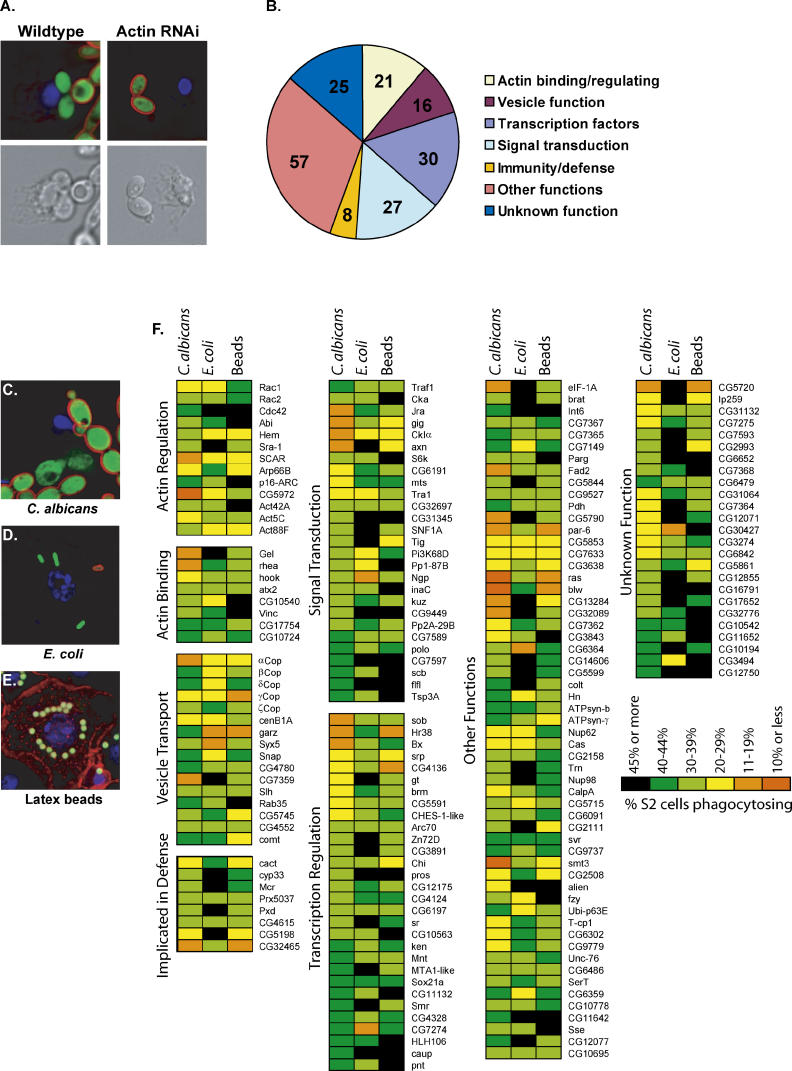
Identification of Genes Required for Phagocytosis of C. albicans
(A) High-throughput assay for phagocytosis. GFP-expressing C. albicans (green) were co-incubated with S2 cells to allow phagocytosis. Cells were lightly fixed, and non-phagocytosed C. albicans were secondarily labeled with a rabbit anti–C. albicans antibody and Cy3-labeled anti-rabbit antibody (red). S2 cell DNA (blue) was labeled with Hoechst 33258. Left panels, wild-type S2 cells; right panels: S2 cells treated with RNAi against actin (Act5C).(B) One hundred eighty-four dsRNAs decreased phagocytosis of C. albicans. The 184 genes were categorized and plotted in a pie graph with the number of genes in each class indicated.(C–E) Secondary screens used to further test the RNAi-treated S2 cells specificity of phagocytosis of C. albicans (C), E. coli (D), or latex beads (E). (C) Phagocytosis of C. albicans. GFP-expressing C. albicans (green) were co-incubated with S2 cells to allow phagocytosis. Cells were lightly fixed, and non-phagocytosed C. albicans were secondarily labeled with an anti–C. albicans antibody and Cy3-labeled anti-rabbit antibody (red). S2 cell DNA was labeled with Hoechst 33258 to mark the position of the S2 cell. The level of phagocytosis was quantified by counting the percentage of S2 cells that had phagocytosed one or more C. albicans. (D) Drosophila S2 cells phagocytose E. coli. GFP-expressing E. coli (green) were co-incubated with S2 cells to allow phagocytosis in a similar assay as (C). Cells were lightly fixed, and an anti–E. coli antibody was used to label non-phagocytosed E. coli (red). The level of phagocytosis was quantified by counting the percentage of S2 cells that had phagocytosed one or more E. coli. (E) Drosophila S2 cells phagocytose 2-μm latex beads. Yellow-green fluorescent latex beads were co-incubated with S2 cells to allow phagocytosis. The S2 cell filamentous actin cytoskeleton was labeled with rhodamine phalloidin (red) and the DNA with Hoechst 33258 (blue). The level of phagocytosis was quantified by counting the percentage of S2 cells that had phagocytosed one or more latex beads.(F) One hundred eighty-four dsRNAs disrupt the phagocytosis of C. albicans by S2 cells. The genes required for phagocytosis of C. albicans are listed along with the effect on phagocytosis of E. coli and latex beads. The color-based scale is given below and corresponds to the percentage of S2 cells that phagocytosed one or more C. albicans, E. coli, or latex beads. Genes were categorized based upon function as in (B). Mean values for phagocytosis by wild-type, untreated S2 cells were: C. albicans 52%, E. coli 56%, and latex beads 51%.